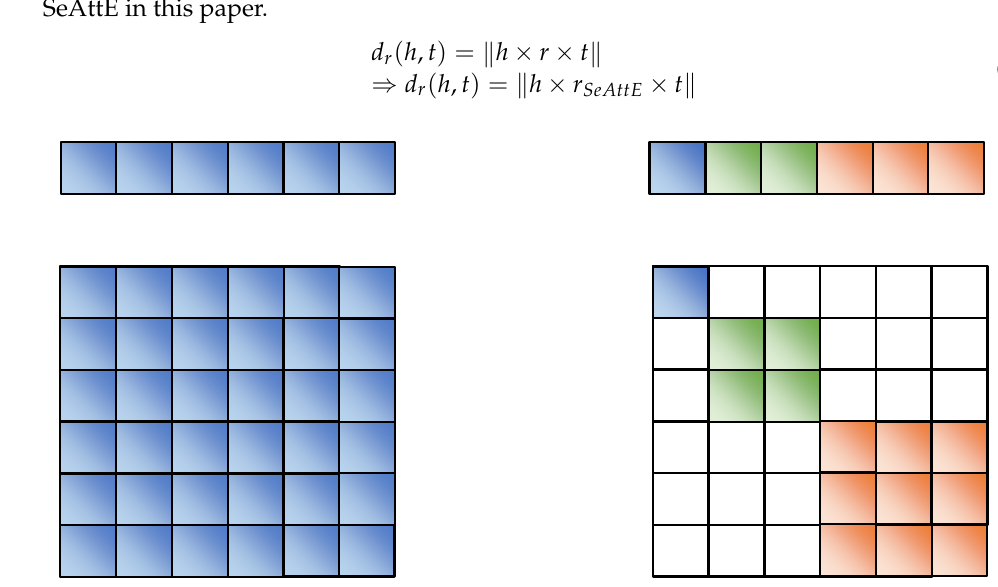
Figure 3. The left is the traditional entity vector and relation matrix, the right is the entity vector and the relation matrix with the separation of attribute